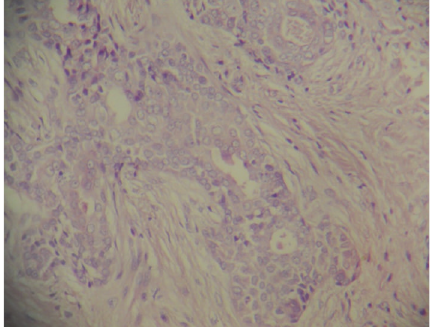
Figure 4: Histopathological picture showing microcysts formation within the epithelial